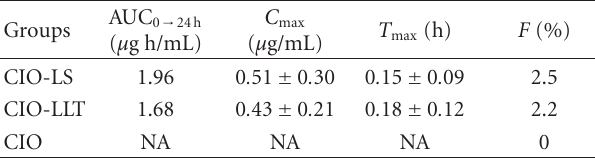
Table 2: Characteristics of the CIO-loaded tablet. Table 3: Pharmacokinetic parameters after oral administration of CIO, CIO-LS, and CIO-LLT to rats. CIO-loaded tablet